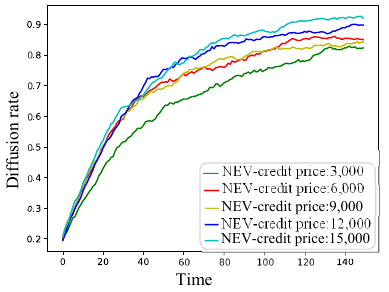
Figure 12. Sale profit, Small world.